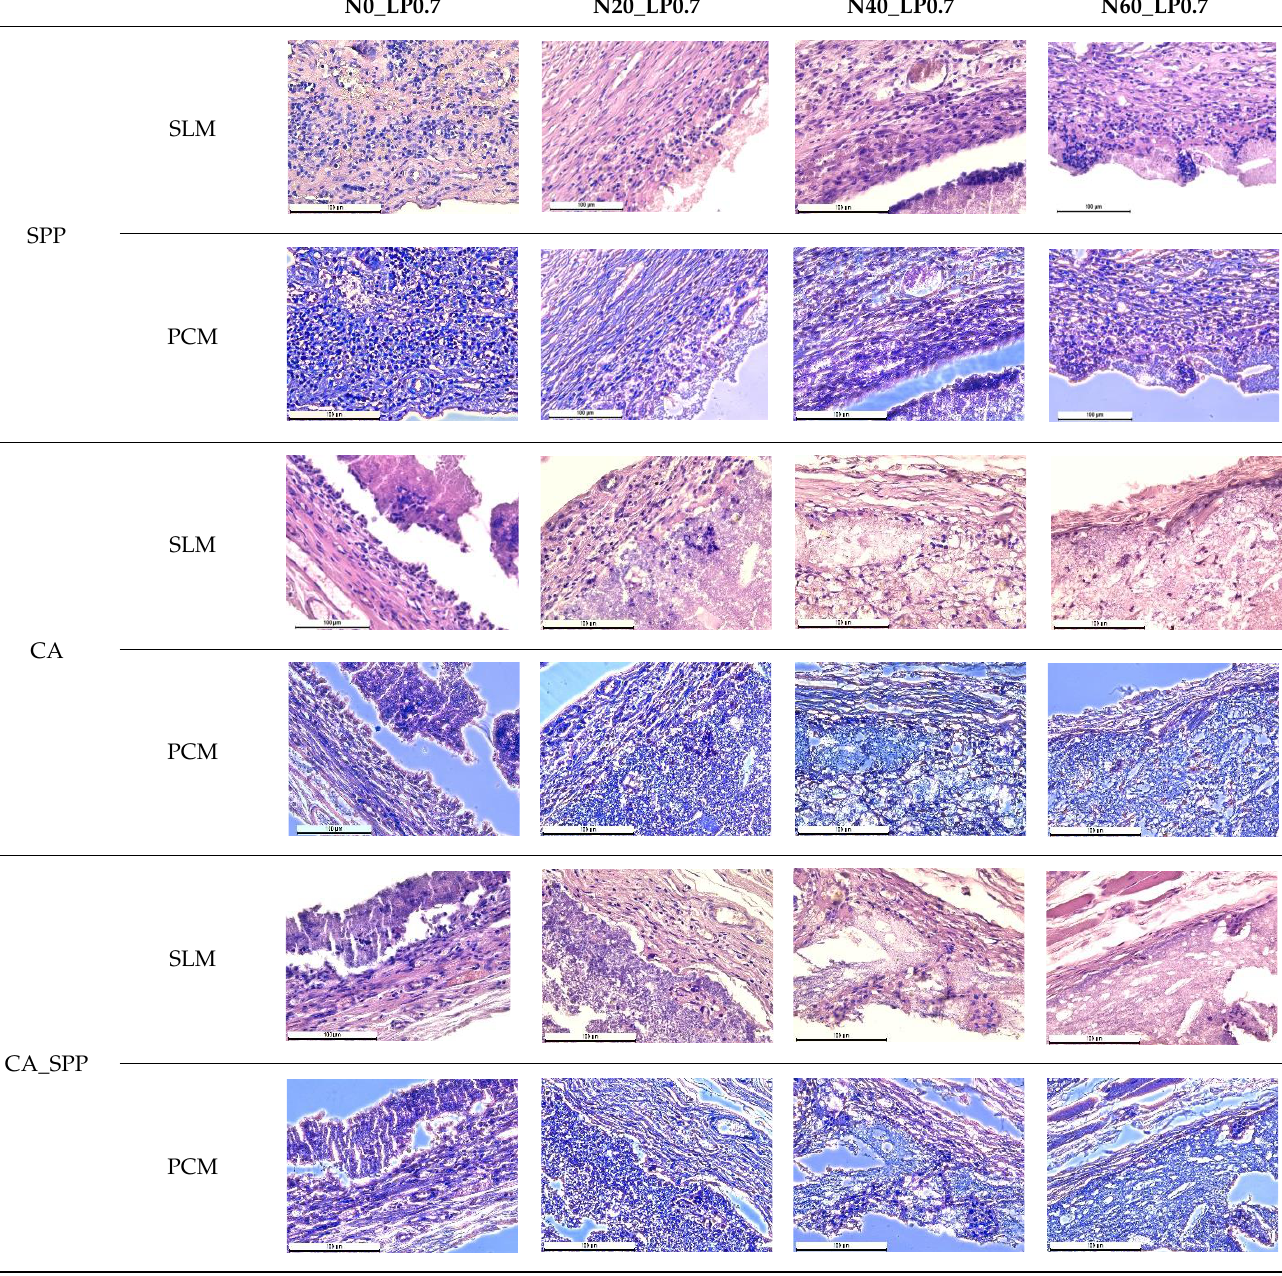
Table 9. The average thickness of fibrous capsules (µm) and the relative area of vessels per 100 thousand µm 2 of capsule area. * — significant differences.